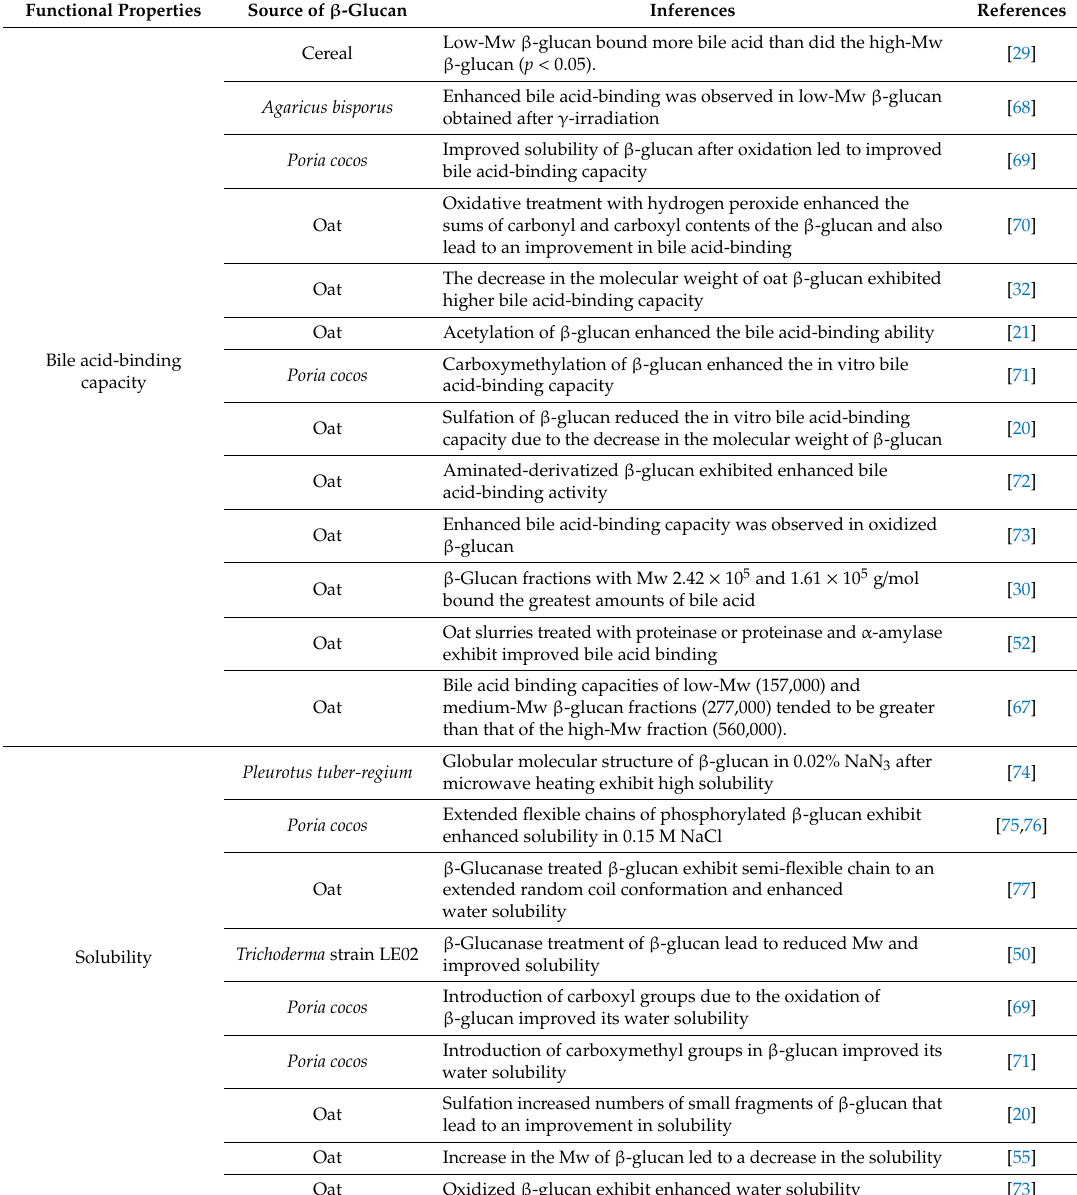
Table 3. The functional properties of β -glucan extracted from various